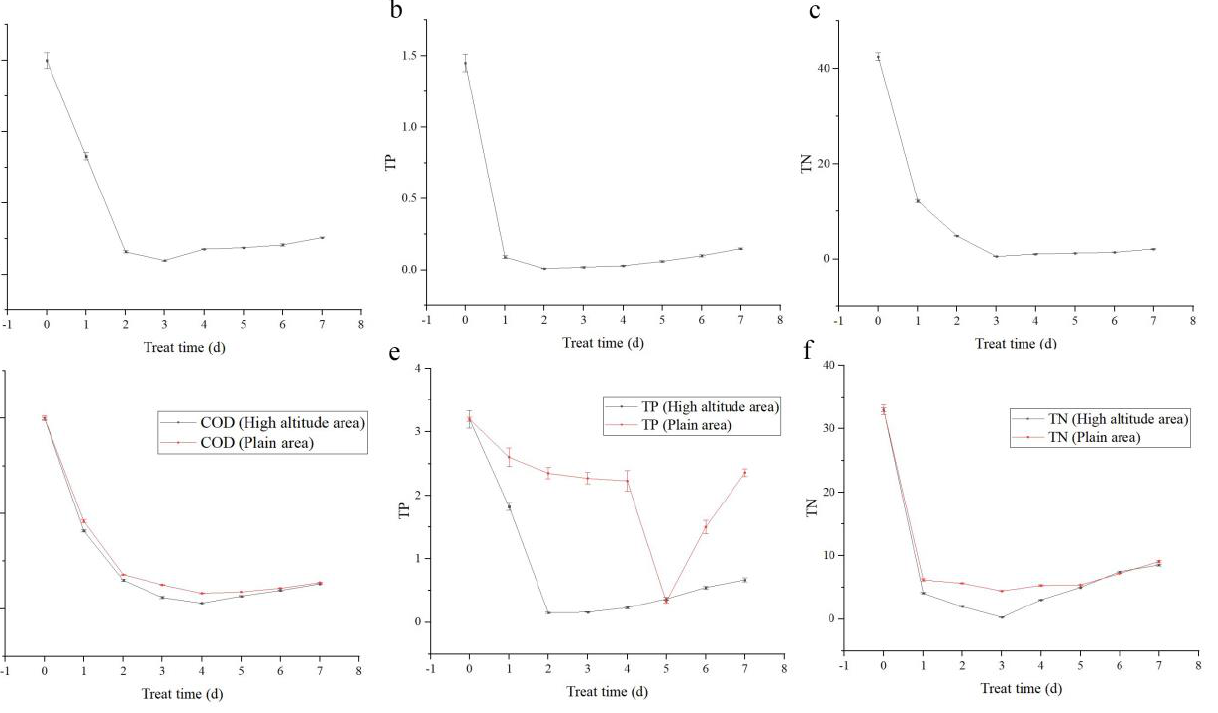
Figure 2. Application of Desmodesmus sp. in actual sewage treatment, and comparative experiment of sewage treatment. ( a ) COD treatment trends; ( b ) TP treatment trends; ( c ) TN treatment trends. Positive control experiment of Desmodesmus sp. from plateau and plain areas: ( d ) COD treatment trends; ( e ) TP treatment trends; ( f ) TN treatment trends.